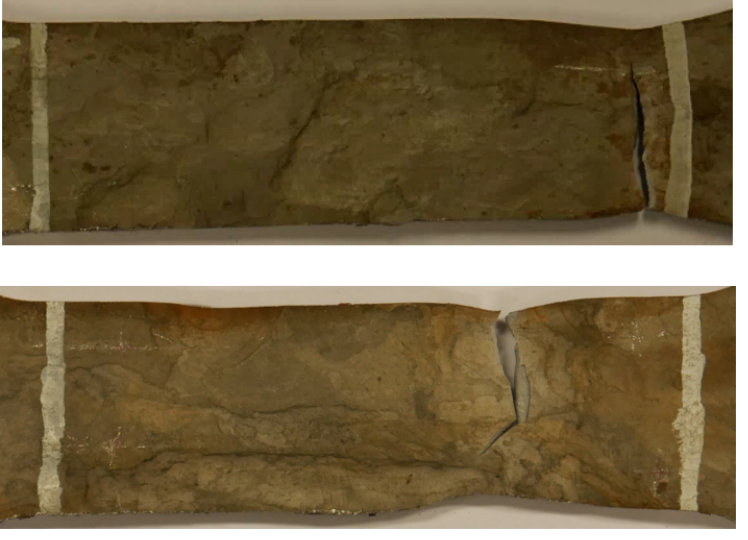
Figure 4. Tested specimens